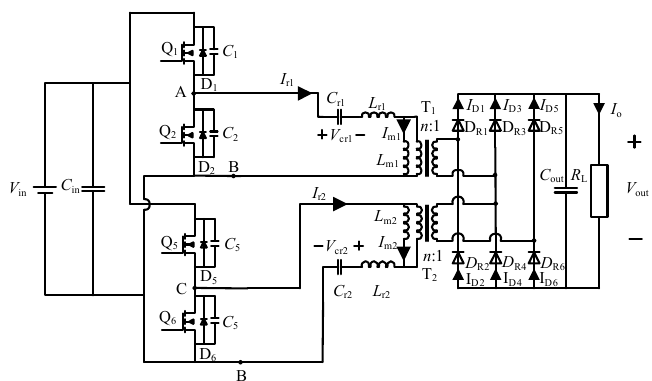
Figure 7. Equivalent circuit diagram for the half ‐ bridge phase ‐ shift mode.